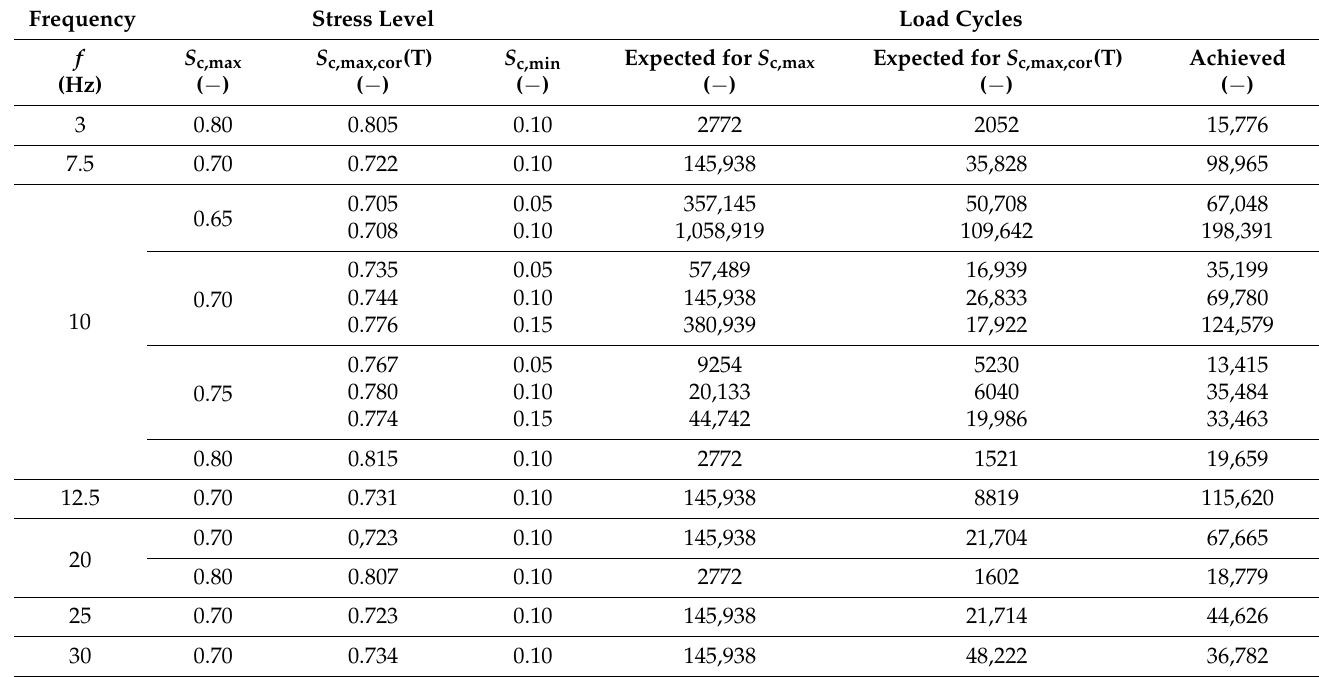
Table 3. Result overview of the presented correction method based on average values of the maximum stresses and the required number of load cycles for all series without